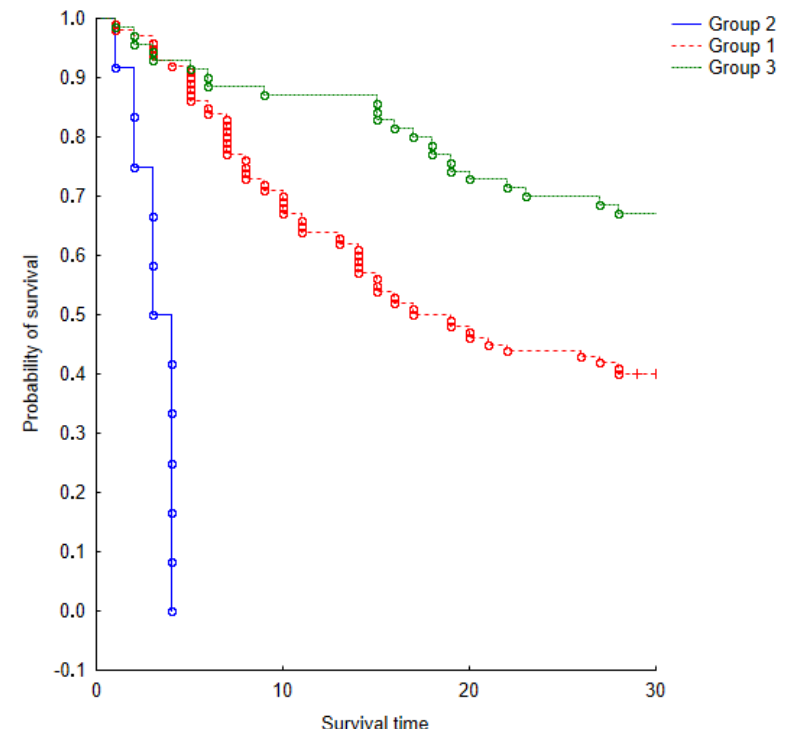
Figure 5. The Kaplan-Meier survival model for three groups of activity of experience over a period of one